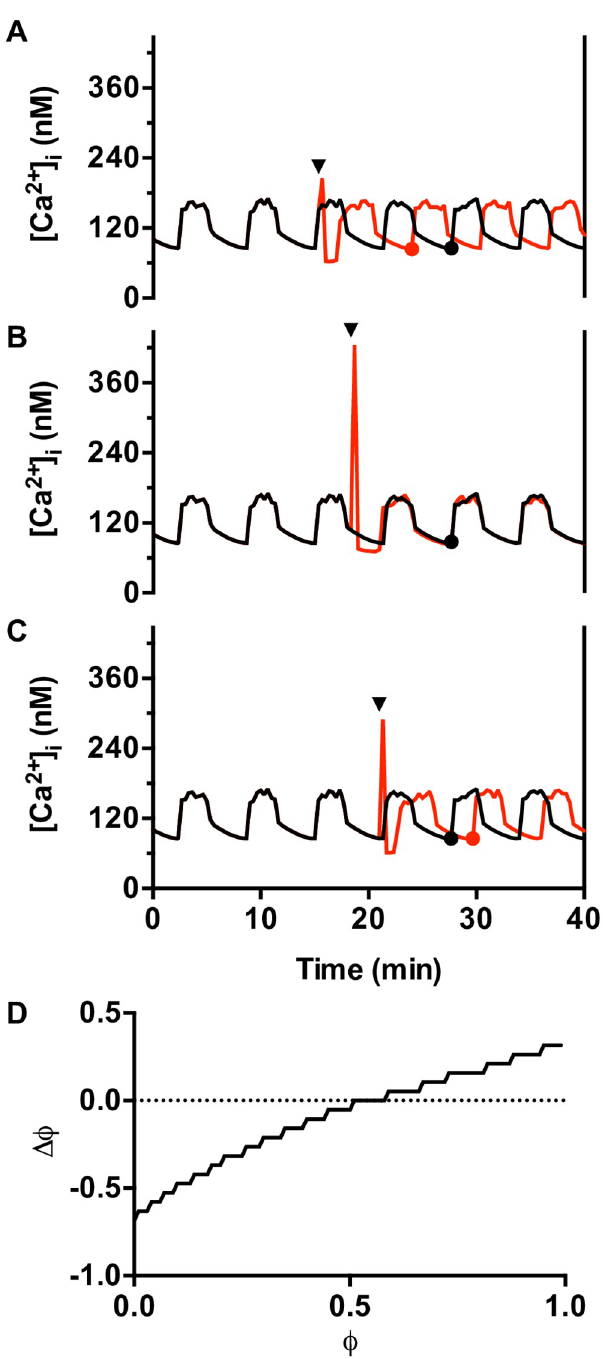
Fig 5. Phase responses of a model islet oscillator to a single pulse of IP 3 . Unperturbed model islet oscillations are shown in black. The red trace shows the model islet perturbed with a single 10 sec IP 3 pulse applied at 20 min. (A) When applied during a burst active phase the IP 3 pulse terminates the burst and there is an advance in the timing of the next active pase. (B) When applied early in a silent phase there is little effect on the phase of the islet oscillator. (C) When applied late in a silent phase there is a delay in the next burst. (D) A phase response curve showing the effect of an IP 3 pulse on the phase of the islet oscillator. Phase 0 is the beginning of a burst active phase, while phase 1 is the end of the subsequent silent phase. The abscissa shows the phase at which the stimulus was applied, while the ordinate shows the effect the perturbation has on the phase as determined by the difference in timing of the unperturbed nadir (black circle in panels above) and the perturbed nadir (red circle). A negative phase difference means a phase advance, while a positive difference means a phase delay.